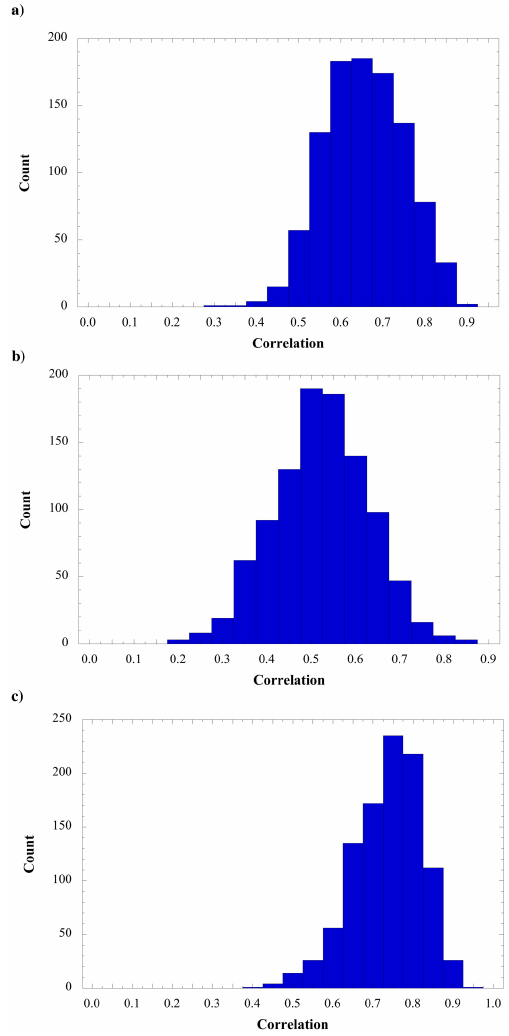
Figure 4. Histogram of correlation values for IMFs in case 1 corre- lated with the (a) 13-year, (b) 55-year, and (c) 80-year